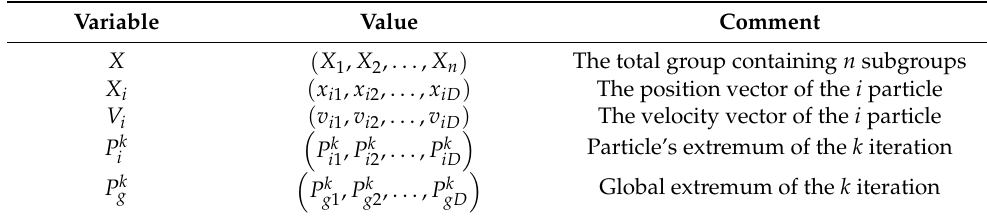
Table 1. Parameter definition in PSO